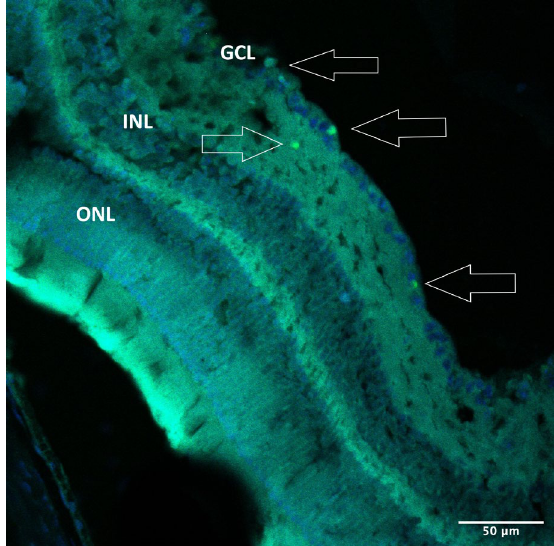
Figure 9. TUNEL immunohistochemical staining in AZ-treated eyes. Few TUNEL-positive apop- totic cells are noted in green in the RGC layer, indicating ganglion cells’ apoptosis death following glaucoma induction (arrows). TUNEL, in situ TdT-mediated dUTP nick end labeling; AZ, azithromycin; RGC, retinal ganglion cell.